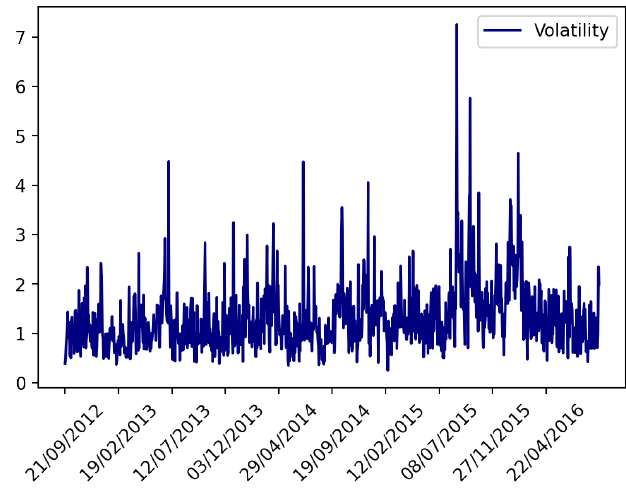
Figure 3. Daily volatility measured using the complete dataset.